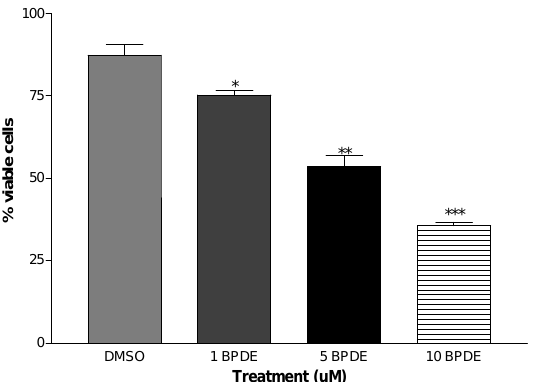
Figure 2 : Cytotoxicity of BPDE to DU145 cells as determined by the MTT Assay. Data presented are the means ± SEMs from three experiments in triplicate. The symbol (*) indicates values significantly different from the control. The symbol (**) indicates values significantly different the 1 μ M BPDE treatment group. The symbol (***) indicates values that are statistically significant different from 5µM BPDE treatment group a significance of p<0.05. DNA strand breaks analysis was performed on DU145 cells after exposure to varying concentrations of B[a]P and BPDE for 48 hours via the Comet assay (Fig. 3).